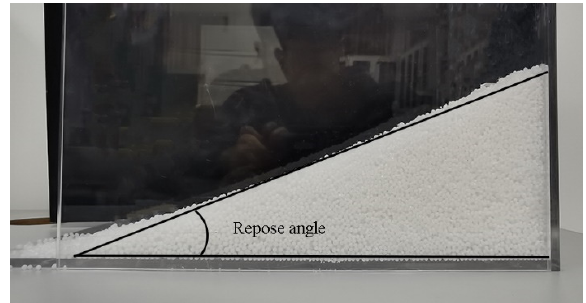
Figure 7. Measurement test of the repose angle. To reduce the measurement repose angle error, MATLAB 2018b (MathWorks, Inc. in the Natick, MA, USA) was used to read the particle stacking image, as shown in Figure 8, according to which the image was grayed out and binarized. Finally, the binarized image edge profile curve was extracted, the least-squares method was used to fit the profile curve to a straight line and the slope of the fitted straight line was the tangent of the repose angle to be measured. After calculation and analysis, the actual repose angle of urea particles was obtained as 22.94 ◦